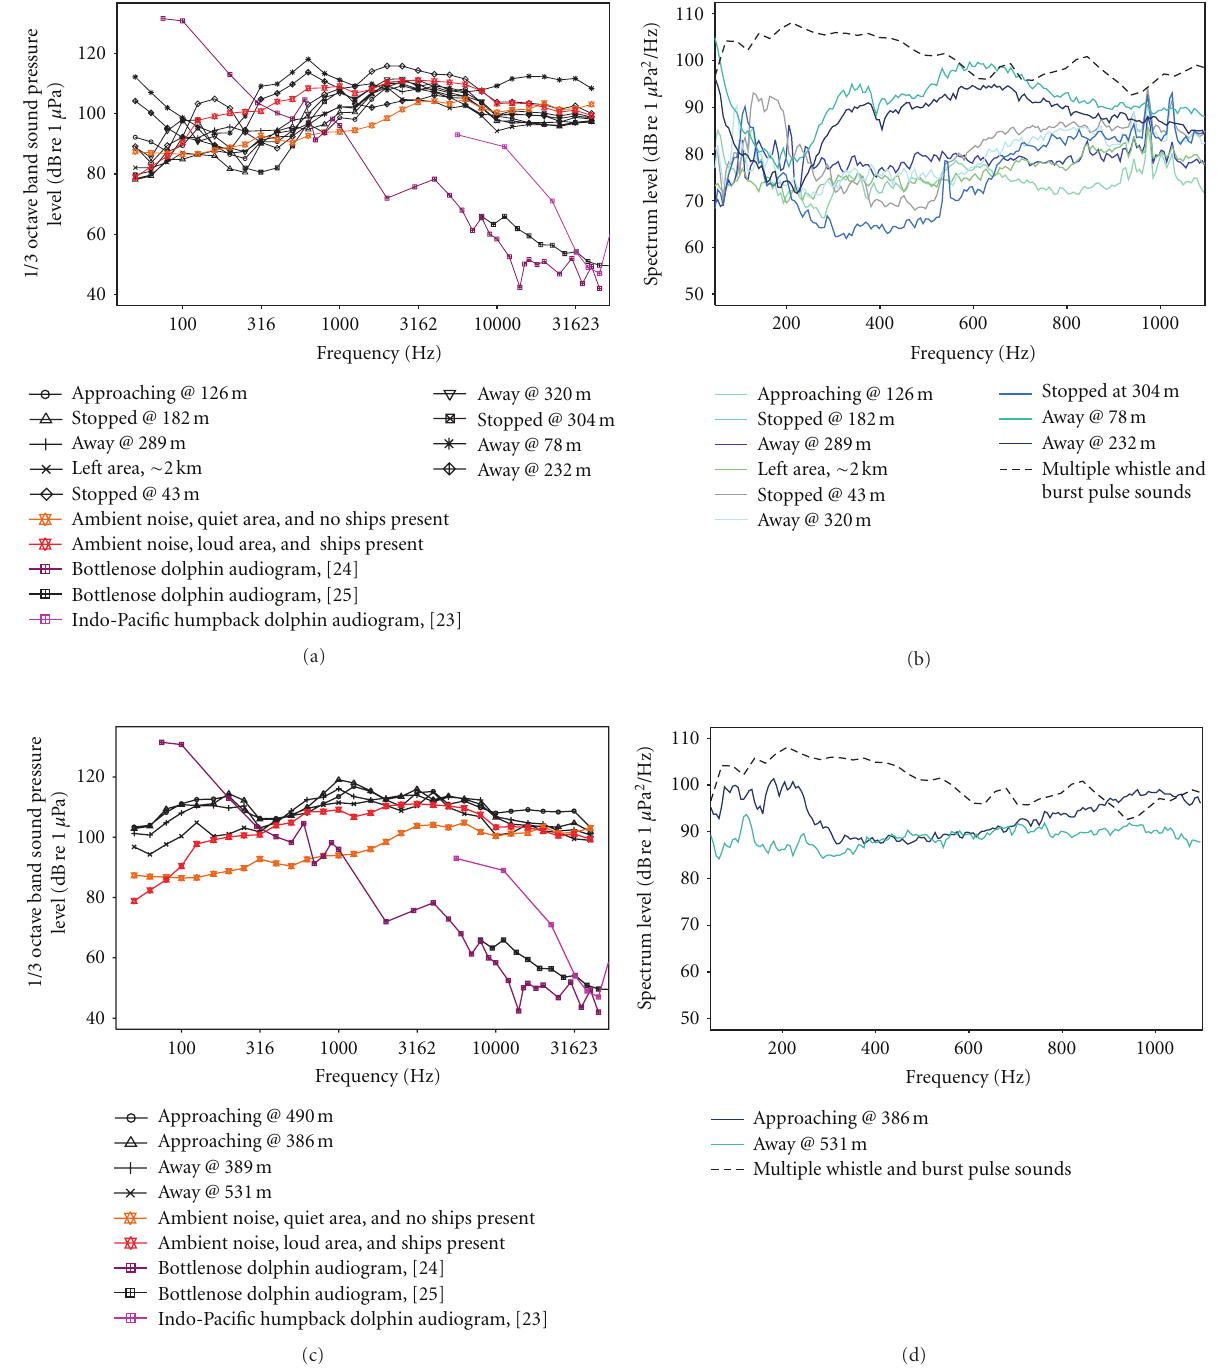
Figure 3: 1/3 octave band sound pressure levels for a small tour boat (referred to as “Wala wala”) in West Lantau (a), Beaufort sea state of 1. The orange line indicates the ambient sounds of Southwest Lantau number 2, located between the Soko Islands with very little boat tra ffi c and no vessels present during recording. The red line indicates South Lantau Vessel Fairway, a busy tra ffi c area, especially for ferries. South Lantau Vessel Fairway was recorded with several ferries and a shrimp trawler present. Selected sound spectra for the small tour boat and humpback sounds are displayed below (b). (c) shows the distribution of sound pressure levels for the Jetfoil high-speed ferry at varying distances, with a Beaufort sea state of 4 at West Lantau Station number 3. The ambient sound levels are the same as those for the small tour boat. (d) shows selected sound spectra for the Jetfoil compared to those of humpback dolphin communication sounds at a distance ≤ 100